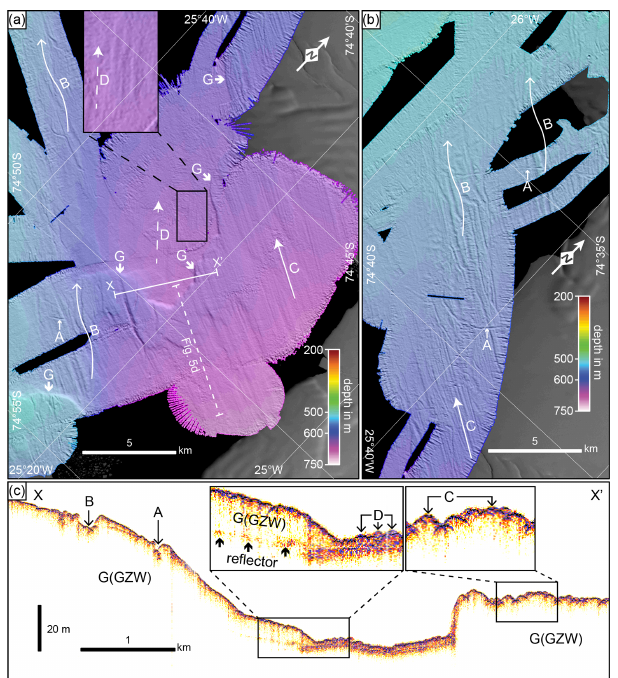
Figure 6. High-resolution bathymetric map from the (a) inner and (b) middle Stancomb-Wills Trough showing plough marks eroded by individual icebergs (Class A) and by icebergs pushed by an ice shelf in a preferred orientation (Class B), glacial lineations (long arrows denote Class C, and long dashed arrows denote Class D), and two grounding-zone wedge (GZW) fronts (bold short arrows, Class G). The acoustic sub-bottom profile (c) , whose location is shown in (a) , crosses landforms of Classes A, B, C, D, and G.